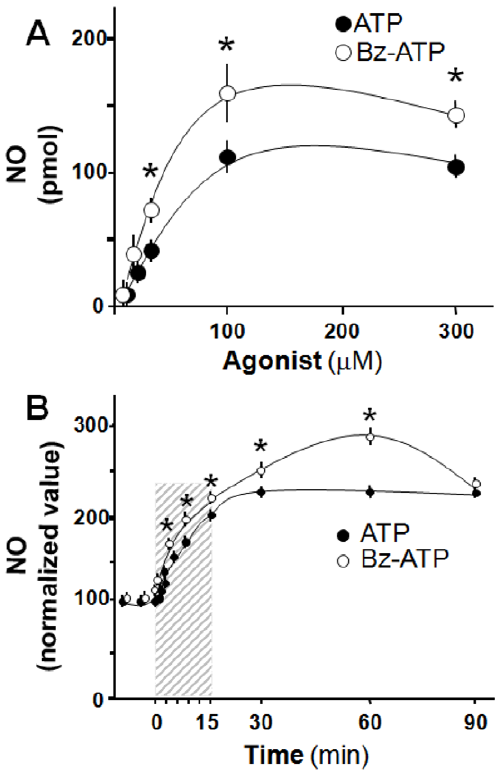
Figure 1. ATP or Bz-ATP induce NO production in hippocampal slices and cultured hippocampal neuron. ( A ): ATP and its analog Bz-ATP, a P2X 7 R preferential agonist, induce NO production in a concentration-depending manner in hippocampal slices; ( B ): In Cultured rat hippocampal neurons (14 DIV), 100 m M ATP or 100 m M Bz-ATP induced a time-dependent surge of NO production, reaching maximal response at 15-min of continuous exposure (shaded bar). In (A) results are expressed as pmol of NO produced per slice. In (B), NO values elicited by nucleotides were normalized with respect to basal values; values represent the mean 6 S.E.M, of triplicate experiments, Student’s t-test *p , 0.05.